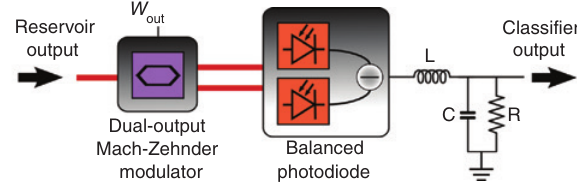
Figure 8: Scheme of the analogue readout layer in Duport et al.